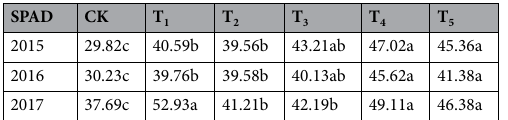
Table 2. Effect of biochar treatment on tobacco chlorophyll.